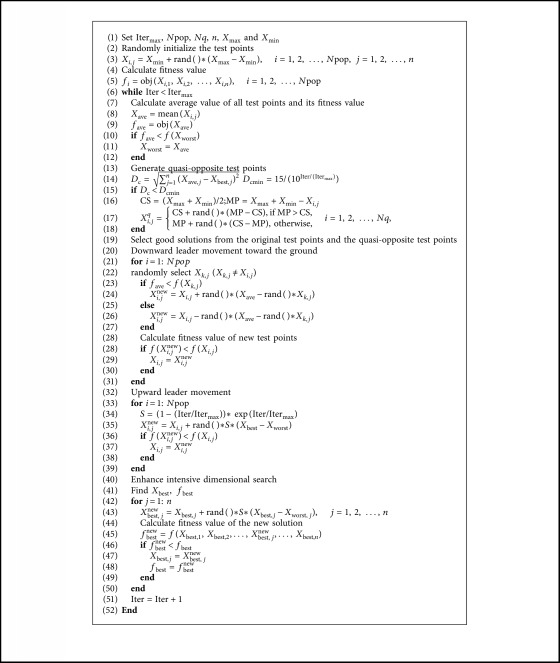
Pseudocode of ELAPO.